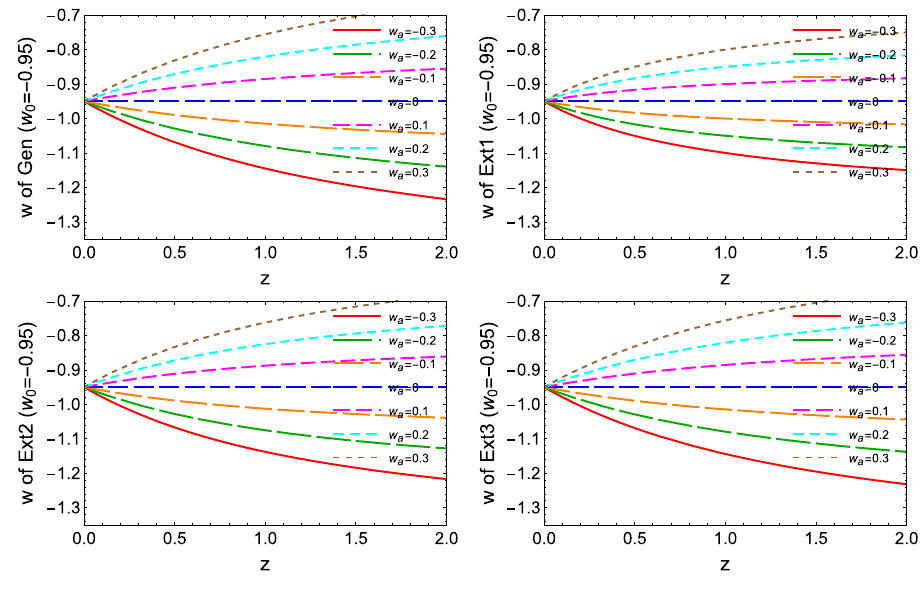
Fig. 1 We show the evolution of the dark energy parametrizations for different values of w a with a fixed value of w 0 = − 0 .